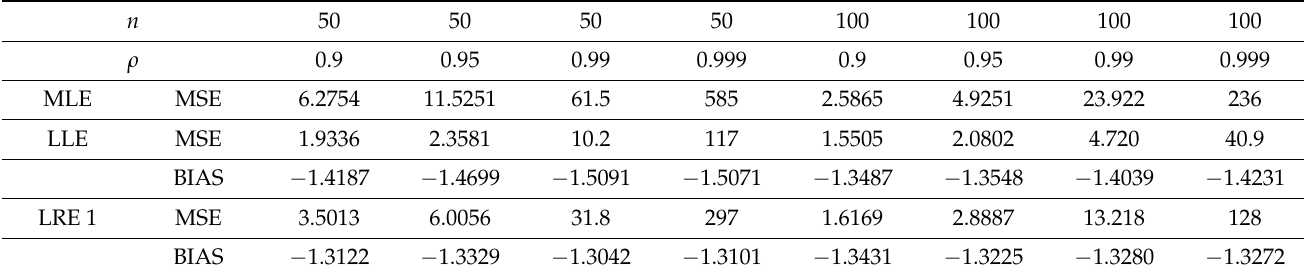
Table 3. Estimated MSEs and Bias for p =